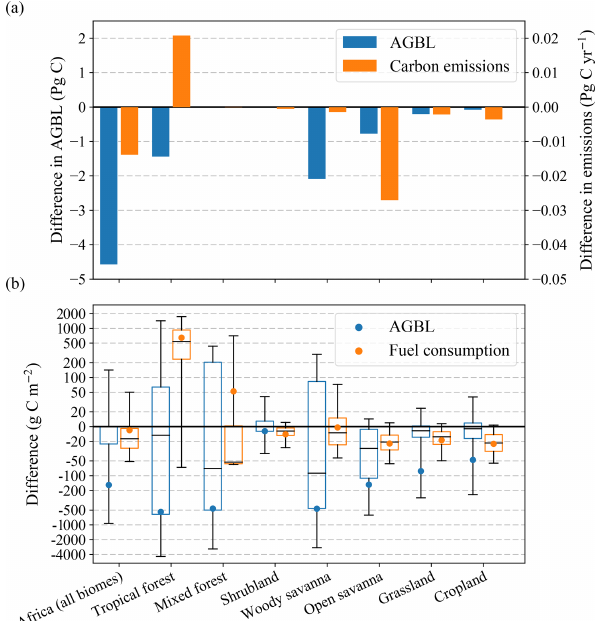
Figure 7. Absolute simulation difference as 0.25 ◦ minus 500m res- olution results for (a) total AGBL and fire emissions and (b) area- average AGBL and FC (per area burned). Boxplots show the mean (coloured dots), median (horizontal line), 25th and 75th percentiles (boxes), and the 5th and 95th percentiles